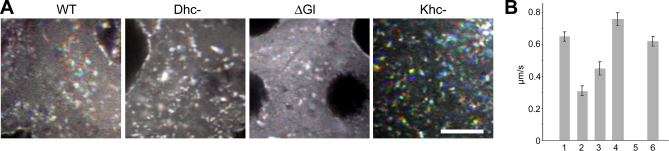
Dynein and Kinesin Have Opposing Effects on GFP-Imp Motility in Nurse Cells(A) Three sequential images are separately pseudocolored red, green, or blue, and overlaid to highlight the frequency of GFP-Imp particle movements in the nurse cell cytoplasm in wild type and mutant backgrounds. Motility is easily discerned in wild type by the resolution of individual colors. After disruption of dynein (Dhc-) or dynactin (ΔGl), there is almost no movement; particles appear white, resulting from the superimposition of red, green, and blue. In contrast, disruption of kinesin I (Khc-) increases particle transport, as demonstrated by the increased visibility of individual colors. Bar, 10 μm. Genetic backgrounds shown include Dhc-, [Dhc6–6/Dhc6–12]; ΔGl, [UASp-ΔGl/+; nanos-GAL4/+]; and khc27, [khc27/ khc27 ] germline clones, as described in the text.(B) Motor mutations affect velocity as well as frequency of GFP-Imp transport events. Histogram illustrates the average velocities of GFP-Imp particles in nurse cells derived from wild type and mutant backgrounds. (1) wild type, (2) Dhc6–6/Dhc6–12, (3) UASp-ΔGl/+; nanos-GAL4, (4) khc27/ khc27germline clone, (5) wild type treated with colcemid, (6) wild type treated with cytochalasin D.